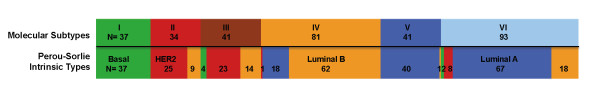
Correlation of the molecular subtypes with the Perou-Sørlie intrinsic types. The top row shows the color-coded molecular subtypes of 327 samples in our dataset, and the lower panel shows how the same cases on top were classified into the basal (green), HER2-overexpressing (red), luminal A (blue) and luminal B (brown) intrinsic types using the classification genes of Sørlie, et al. [2]. The results show both similarities and differences between the results of these two classification methods.